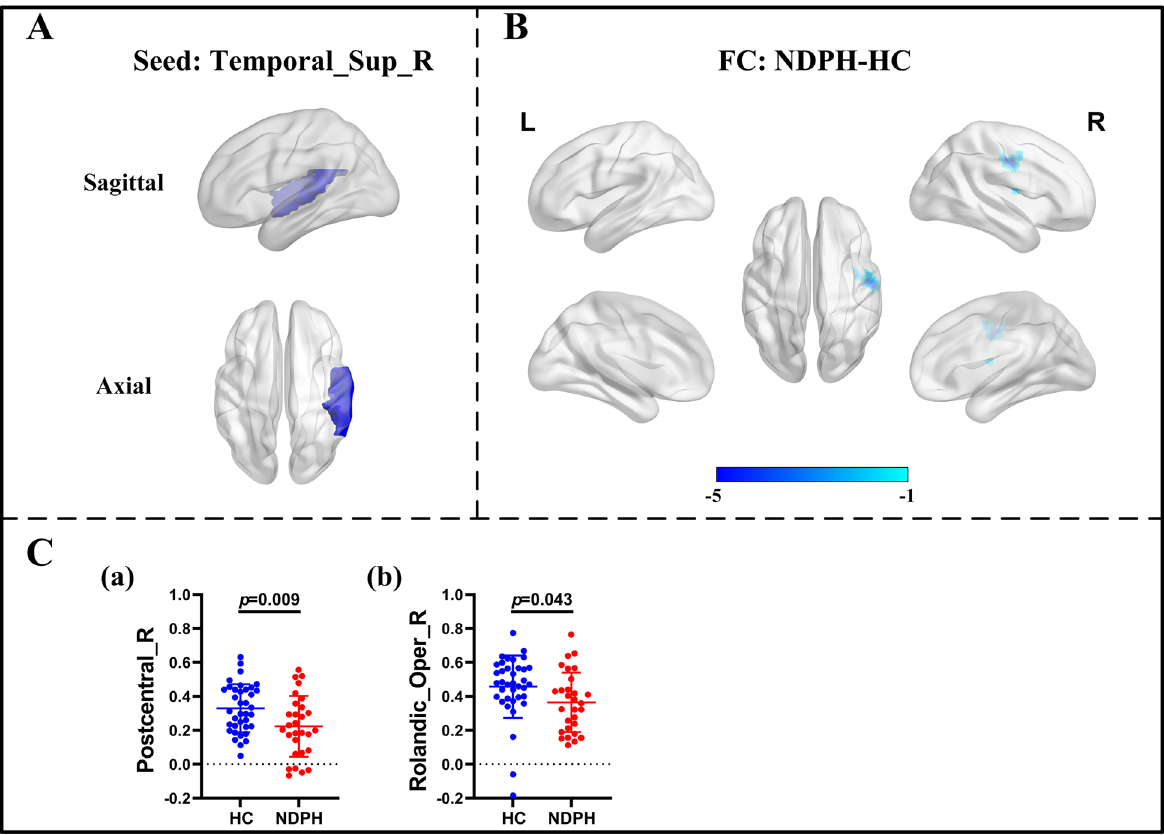
Fig. 6 FC analysis from right superior temporal gyrus to the whole brain voxels in NDPH and HC groups. A The schematic diagram of the seed (right superior temporal gyrus). The brain region marked in blue represents the right fusiform gyrus. B The schematic diagram of significant FC differences. Compared with HCs, patients with NDPH showed significantly increased FC between the seed and right postcentral gyrus, right rolandic operculum. C (a) and (d) represented FC values between the seed and right postcentral gyrus, right rolandic operculum respectively in HC group and patients with NDPH. Notes: The color bar showed t-values of the two-sample t-tests on FC. Abbreviations: L, left; R, right; Oper, operculum; FC, functional connectivity; NDPH, new daily persistent headache; HC, health